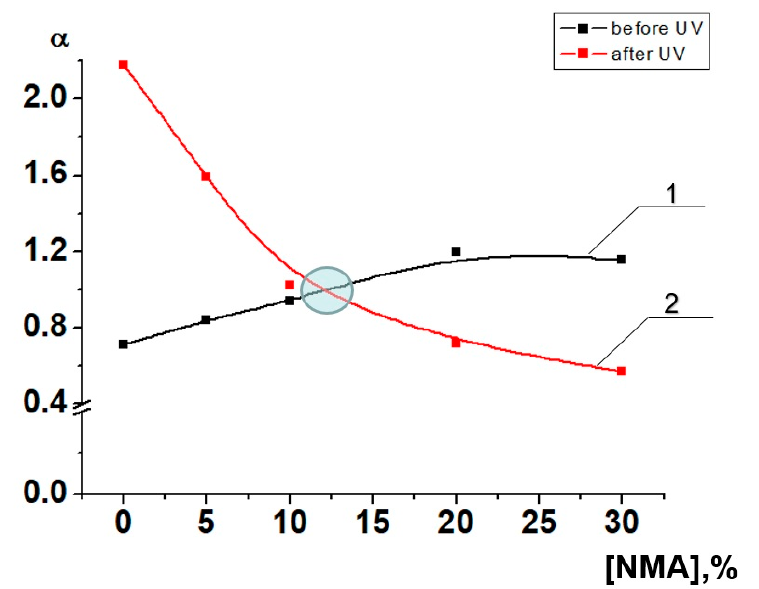
Figure 10. Dependence of the maximum degree of swelling in water ( α ) of chitosan films crosslinked with NMA in the NMA concentration range of 0–30 wt%: (1) without UV irradiation; (2) in the presence of UV irradiation. The standard deviation for all points on the graphs was 0.01 for 5 parallel measurements.